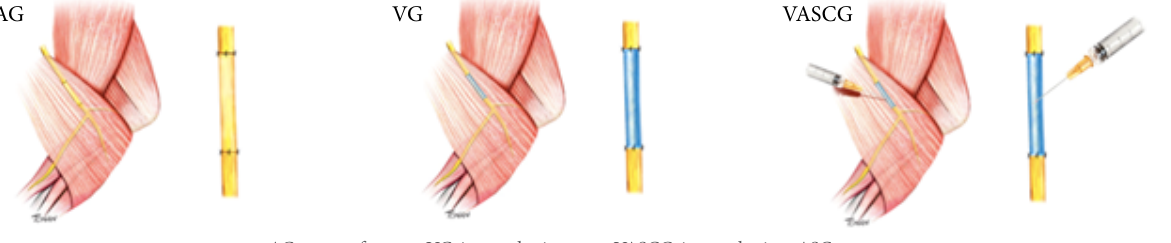
Figure 2 - Methods adopted in the experimental